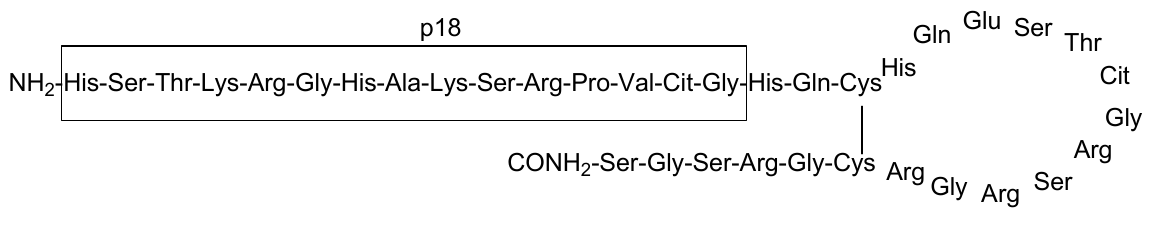
Figure 1. Amino acid sequence of chimeric fibrin/filaggrin citrullinated peptide (CFFCP1). Linear fibrin (p18) is